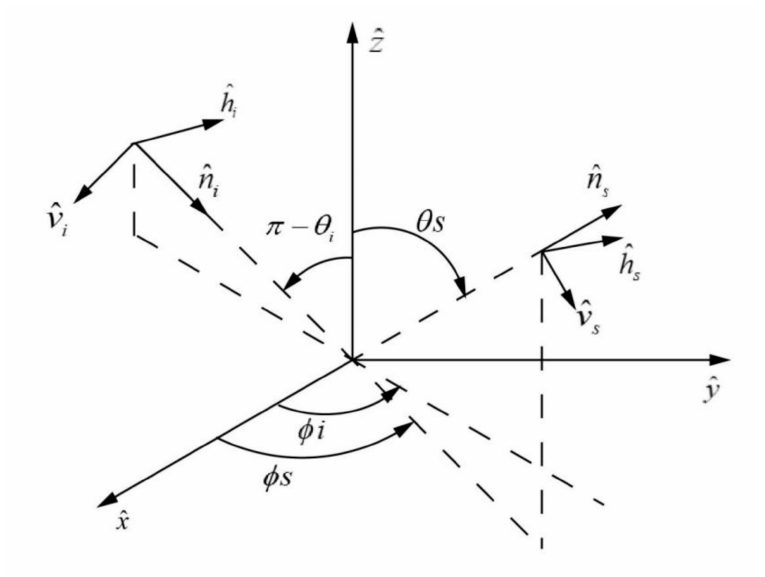
Figure A1. Geometry for FSA